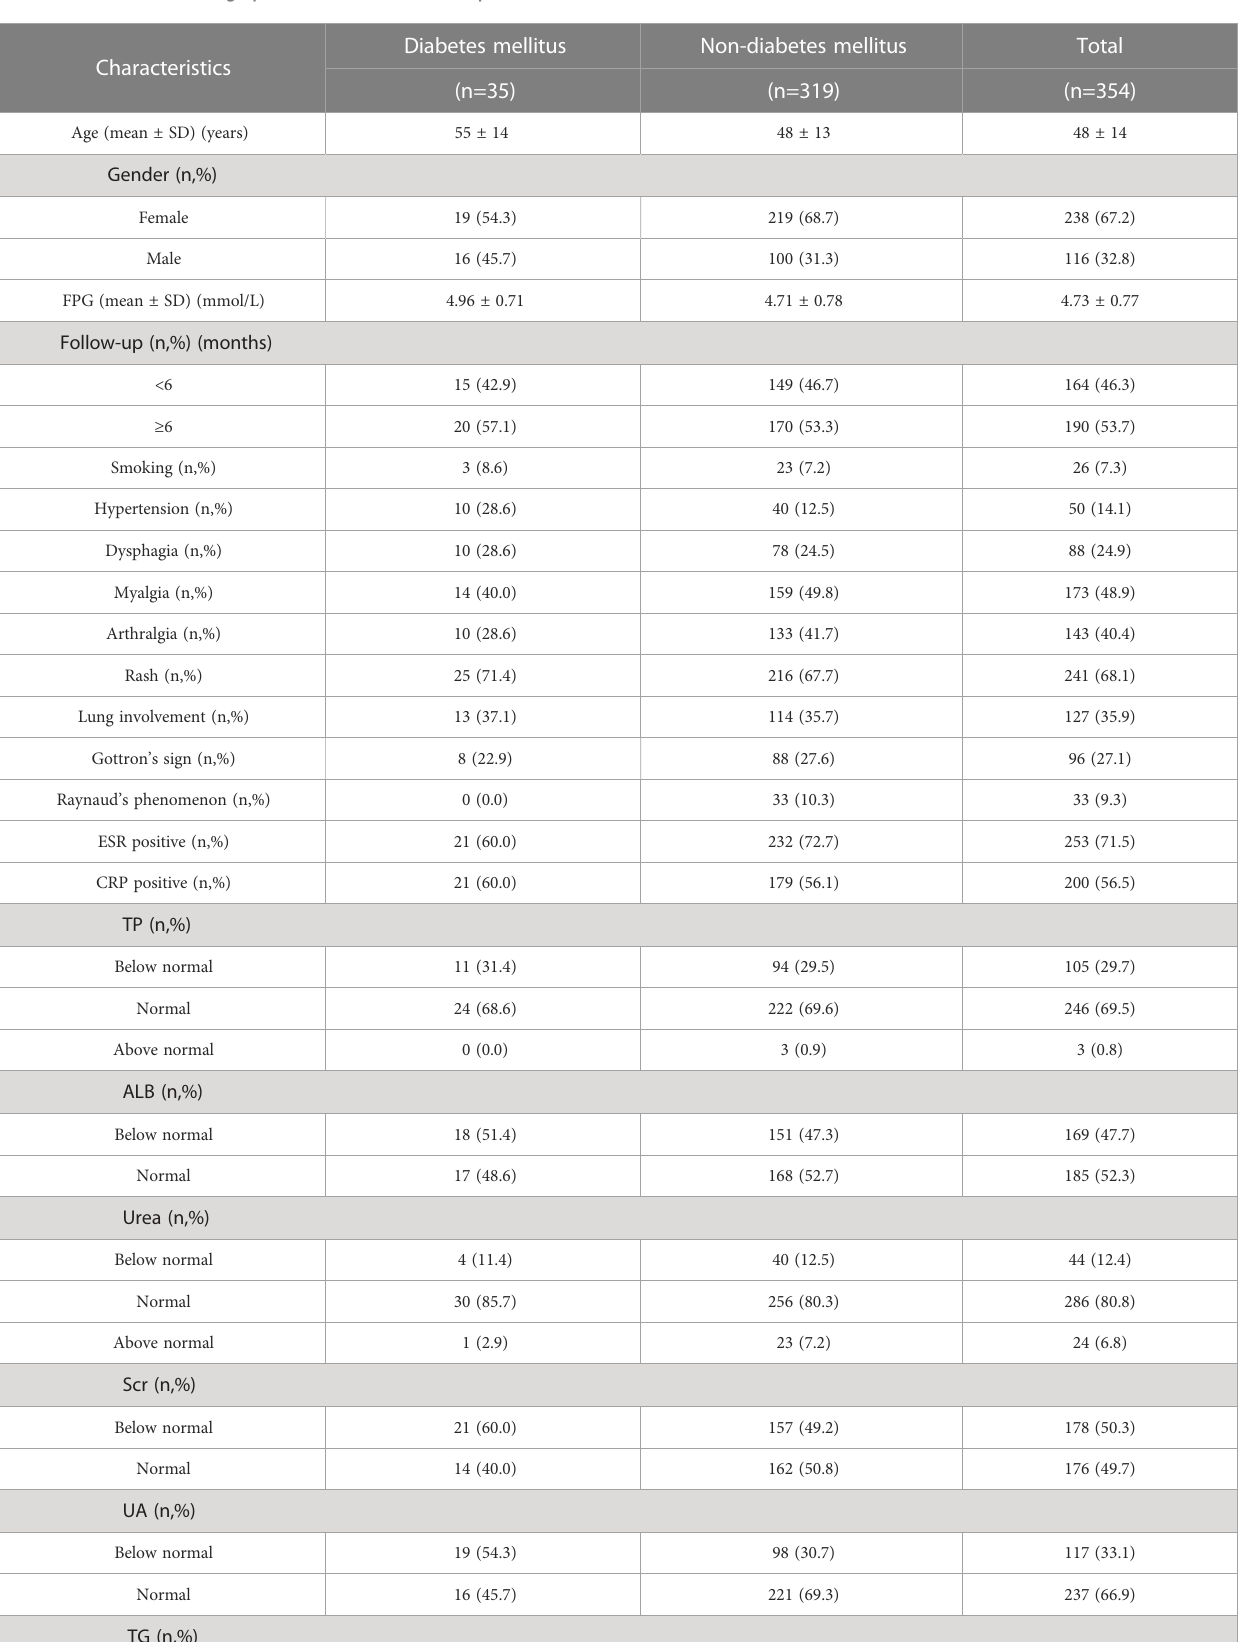
TABLE 1 Clinical and demographic characteristics of IIMs